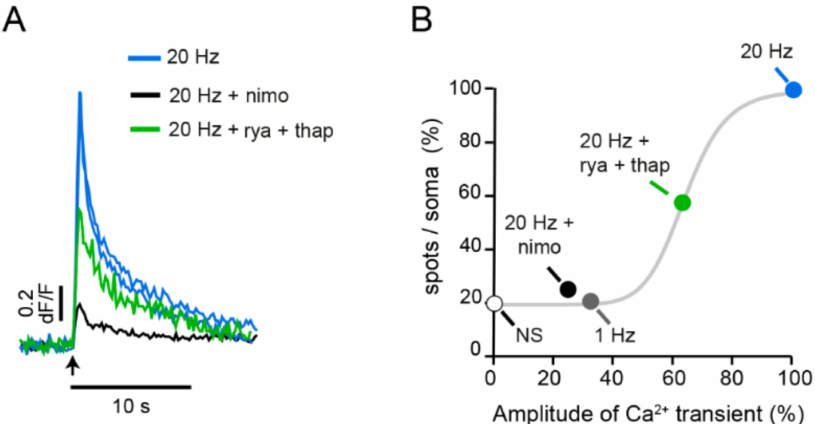
Figure 7. The fast calcium transient determines the amount of exocytosis. ( A ) Kinetics of the fast calcium transient imaged besides the plasma membrane. Application of L-type calcium blocker nimodipine reduces the transient by 80%. Elimination of calcium-induced calcium release by combin- ing ryanodine and thapsigargin reduces the calcium transient by 40%. ( B ) The amplitude of the fast calcium transient determines the amount of release. The grey sigmoidal is the frequency-dependence on the amount of exocytosis. Constitutive exocytosis contributes with ~20% of the spots per soma. NS = on stimulated. Obtained with permission from